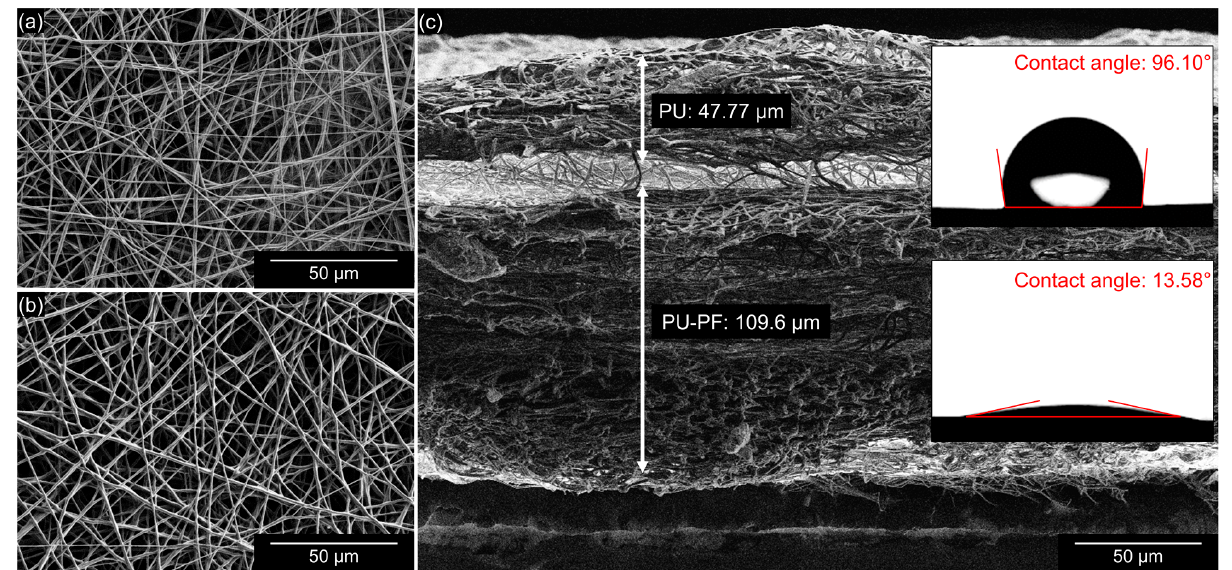
Figure 1. Scanning electron microscopy (SEM) images of ( a ) hydrophobic (PU) side, ( b ) hydrophilic (PU-PF) side, and ( c ) cross section of electrospun bilayer membrane.